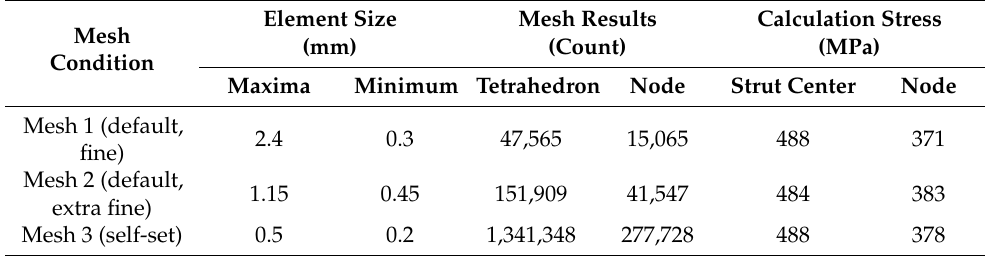
Table 2. Mesh information and calculation stress of the different mesh conditions.